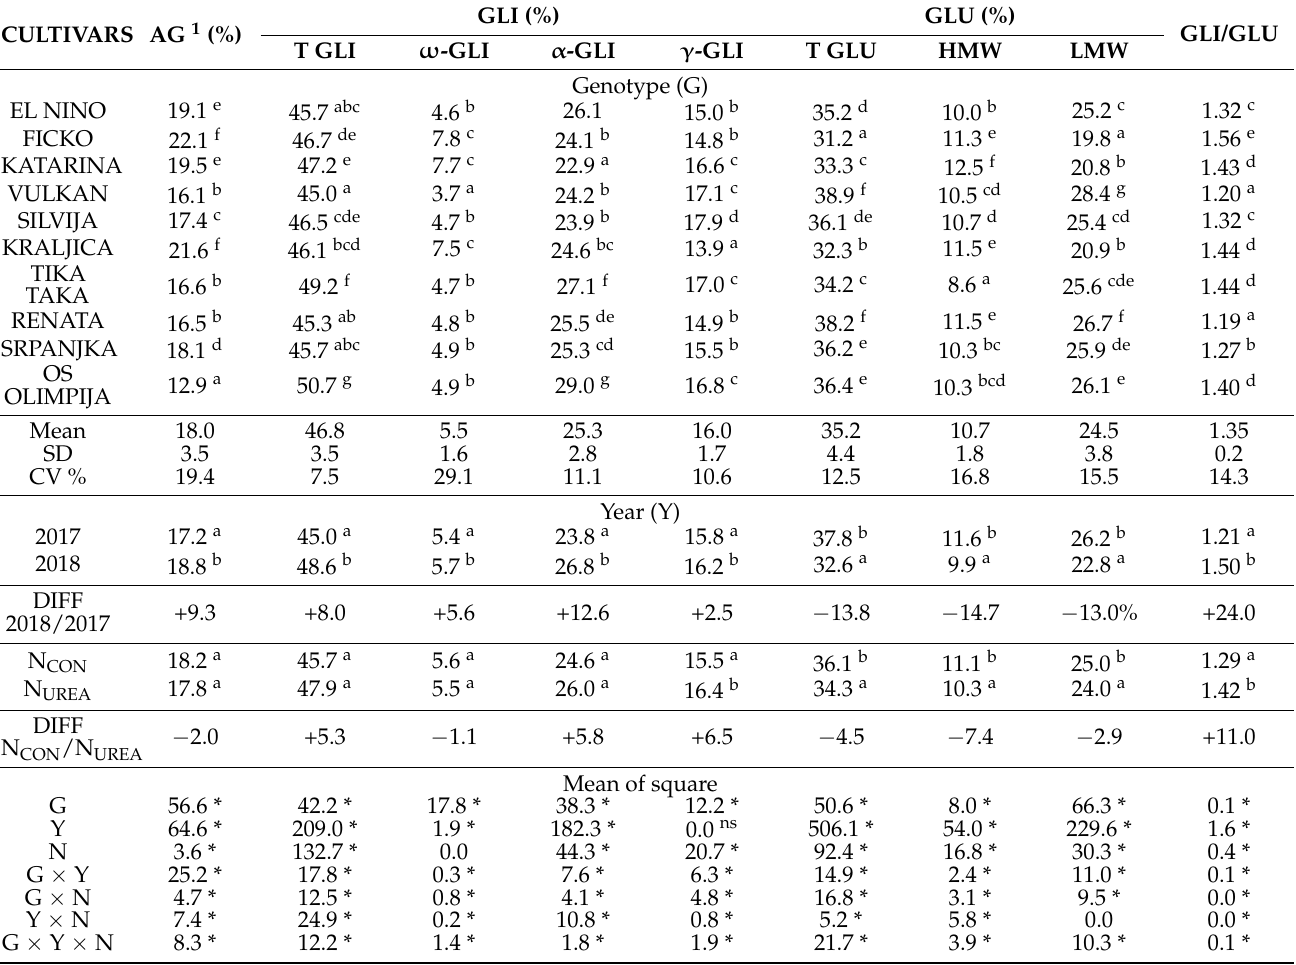
Table 5. The mean values and the effects of the late-season urea application on protein composition of wheat